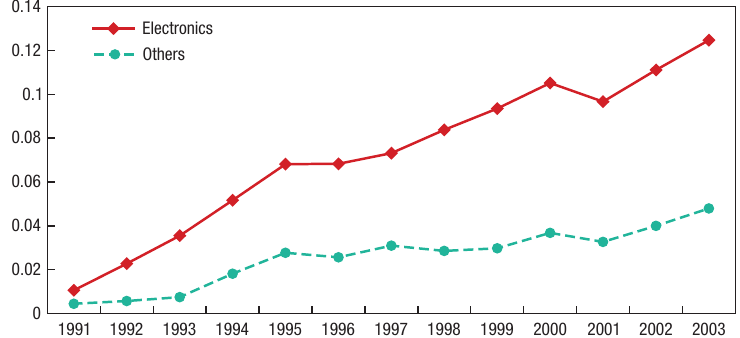
Fig. 6. Year differences in R&D elasticity: electronics vs other manufacturing